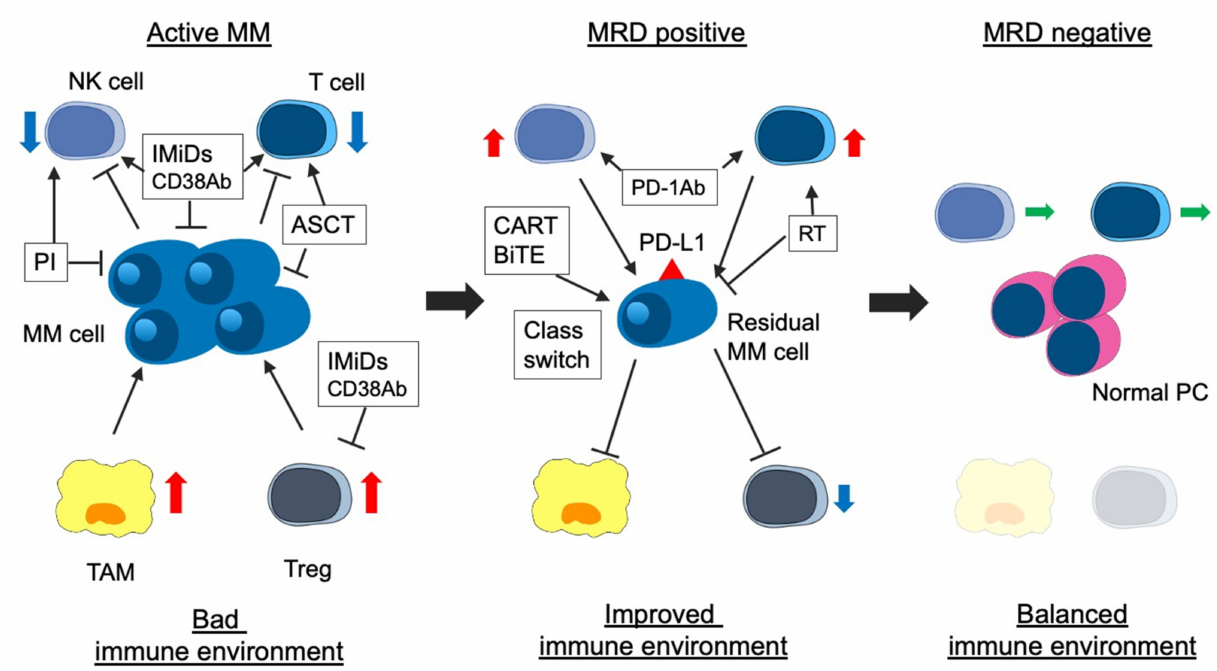
Figure 1. Association between disease status and immune environment in myeloma. The immune environment contributes to immune escape, proliferation, and survival of myeloma cells via several cytokines and activated immunosuppressed cellular components (i.e., TAM and Treg) in patients with active myeloma. IMiDs, PIs, anti-CD38 MoABs, and ASCT improve the immune environment. ASCT contributes to immune reconstitution. In patients with MRD positivity, the immune environment is improving, but immunosuppressive cells are still active. In addition, residual myeloma cells express immune checkpoint molecules (i.e., PD-L1) and escape from immune attack. Two treatment strategies for residual myeloma cells are considered: the first is the activation of immune response using agents with another mode of action (i.e., anti-PD-1 MoAb). The second is a change into a treatment approach suitable for residual myeloma cells (class switch) or a new mode of action agents (i.e., BCMA-targeting CAR-T). Finally, in patients with MRD-negativity, immune-suppressive cells decrease, the activity of immune cells (CTL and NK cells) is equivalent, and immune reconstitution occurs (balanced immune environment). MM, multiple myeloma; MRD, minimal residual disease; IMiDs, immunomodulatory drugs; PIs, proteasome inhibitors; MoAbs, monoclonal antibodies; ASCT, autologous stem cell transplantation; NK cell, natural killer cell; TAM, tumor associated macrophage; Treg, regulatory T cell; PD-1, progress-death 1; PD-L1 progress–death ligand 1; BCMA, B-cell mature antigen; and CAR-T, chimeric antigen receptor T